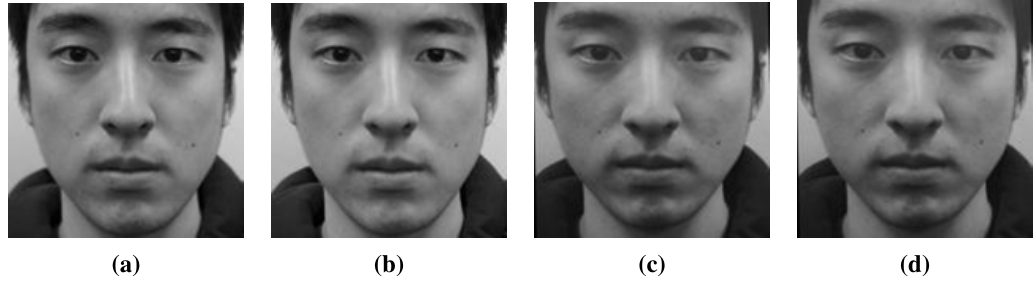
Figure 4. Real face images focused on ( a ) the nose and ( b ) the ear; and fake face images focused on ( c ) the nose and ( d ) the ear.